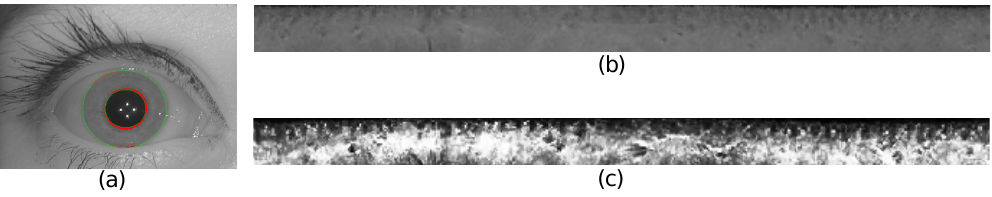
Figure 4. Preprocessing of iris image: ( a ) localization; ( b ) normalization; and ( c ) contrast enhancement. To classify whether two irises (left and right) are from the same or different individuals using the as-modified VGG16 model, we carried out feature fusion of a left and a right greyscale irises so as to form an RGB image as the model input. We combined left and right iris images and a blank image (all pixels have a value of zero), all of which are 8-bit greyscale, into an RGB24 image, as illustrated in Figure